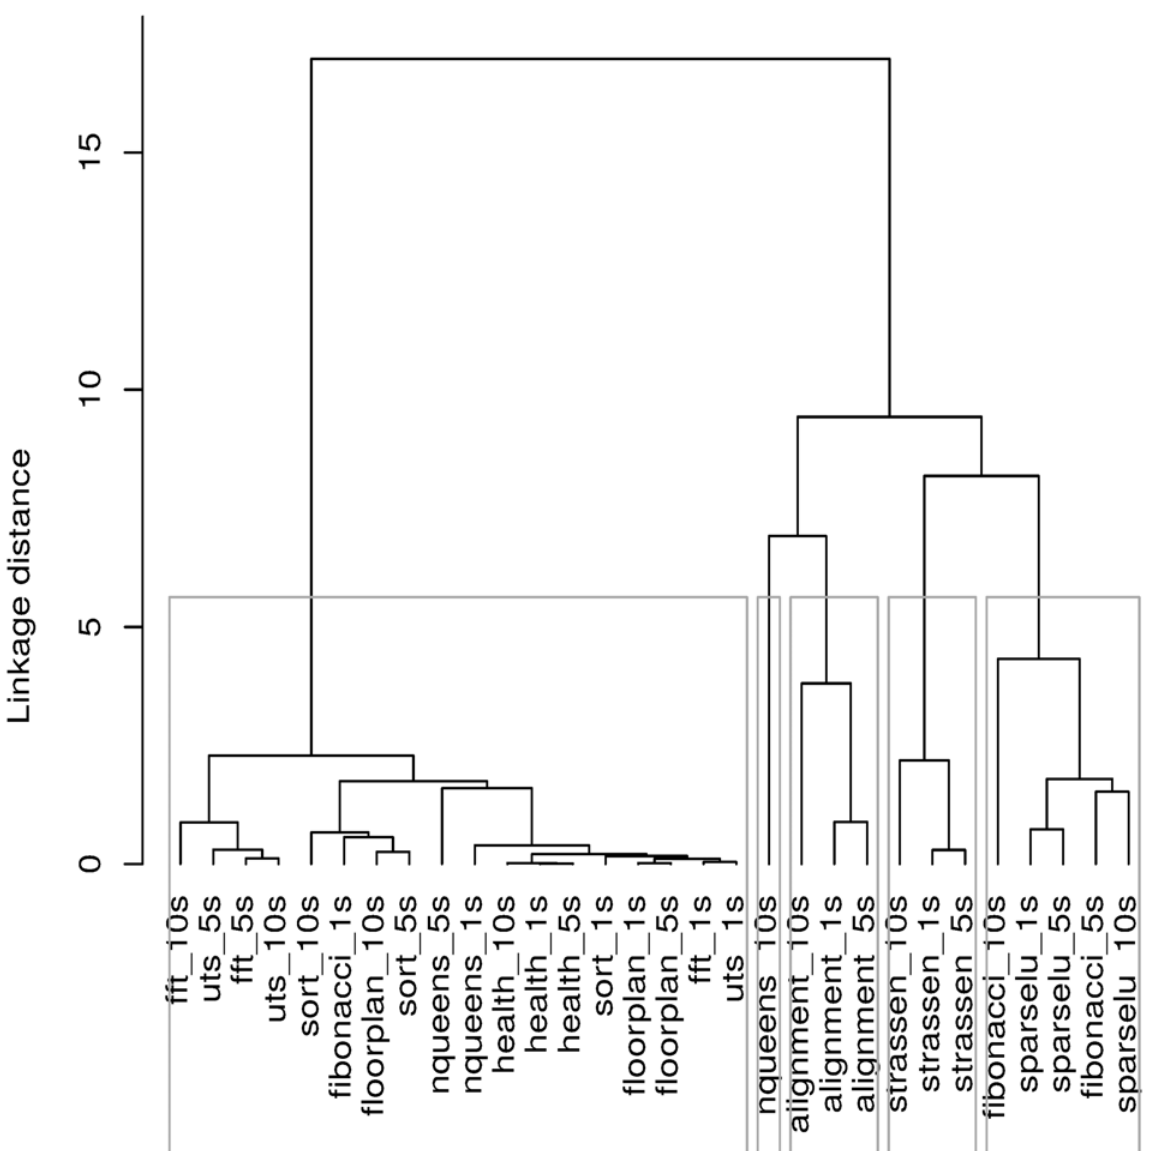
Fig 8. Hierarchical clustering dendogram with a 5-cluster